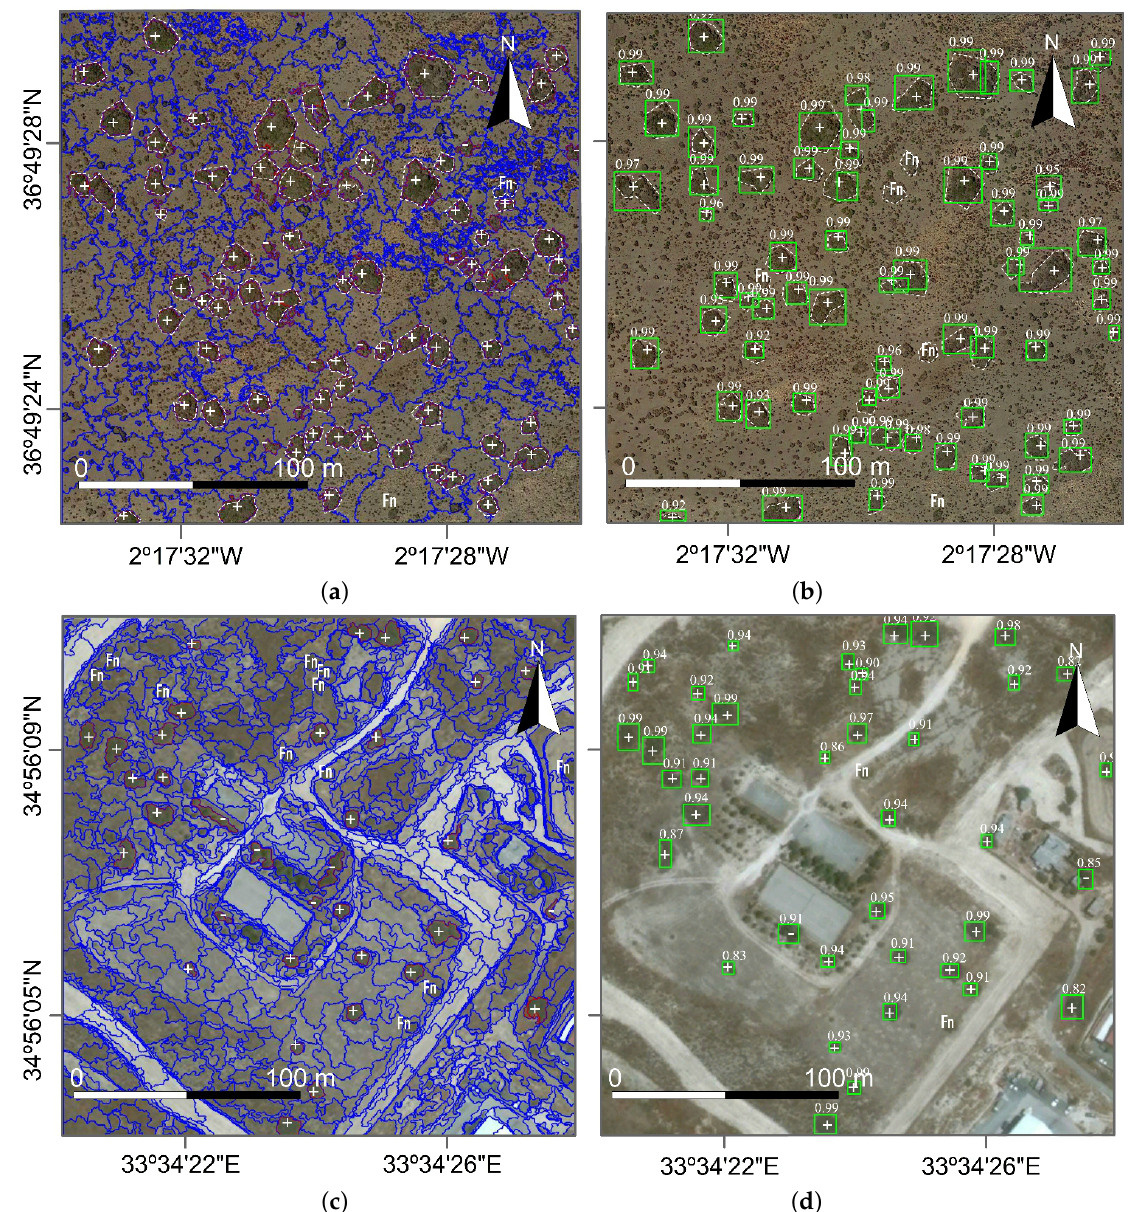
Figure 6. Shrub detection maps obtained with OBIA-based model in test-zone-1 ( a ) and test-zone-2 ( c ) and CNN-based model in test-zone-1 ( b ) and test-zone-2 ( d ). The symbols (+), (-) and (Fn) stand for true positive, false positive, and false negative, respectively. The values on the top of the bounding boxes in (2) and (4) show the probabilities, calculated by ResNet-detector, of having a Ziziphus lotus shrub. ( a ) OBIA detection on test-zone-1; ( b ) CNN detection on test-zone-1; ( c ) OBIA detection on test-zone-2; ( d ) CNN detection on